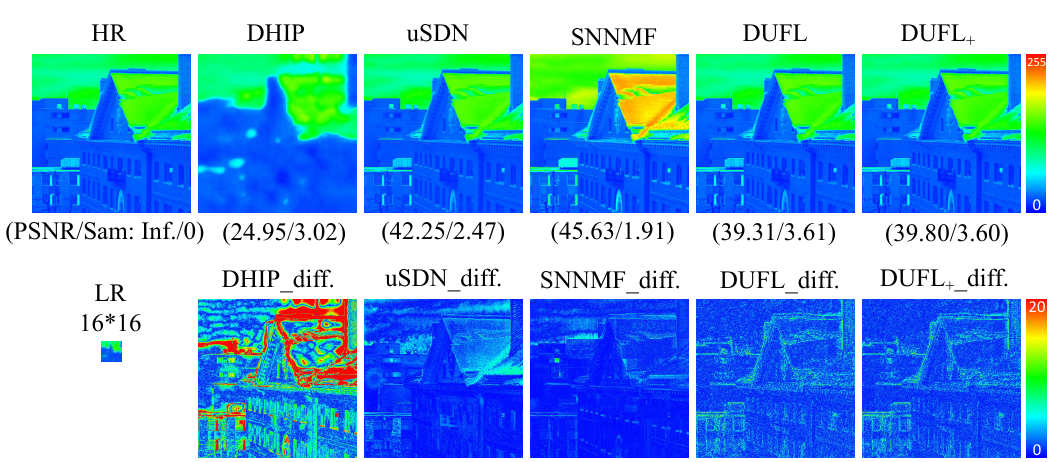
Figure 7. Recovered HR-HS image of the (cid:48) img1 (cid:48) sample in the Harvard dataset using the DHIP [24], uSDN [41], SNNMF [51], and the proposed methods and corresponding difference images between the ground-truth and recovered images with an upscale factor of 16.